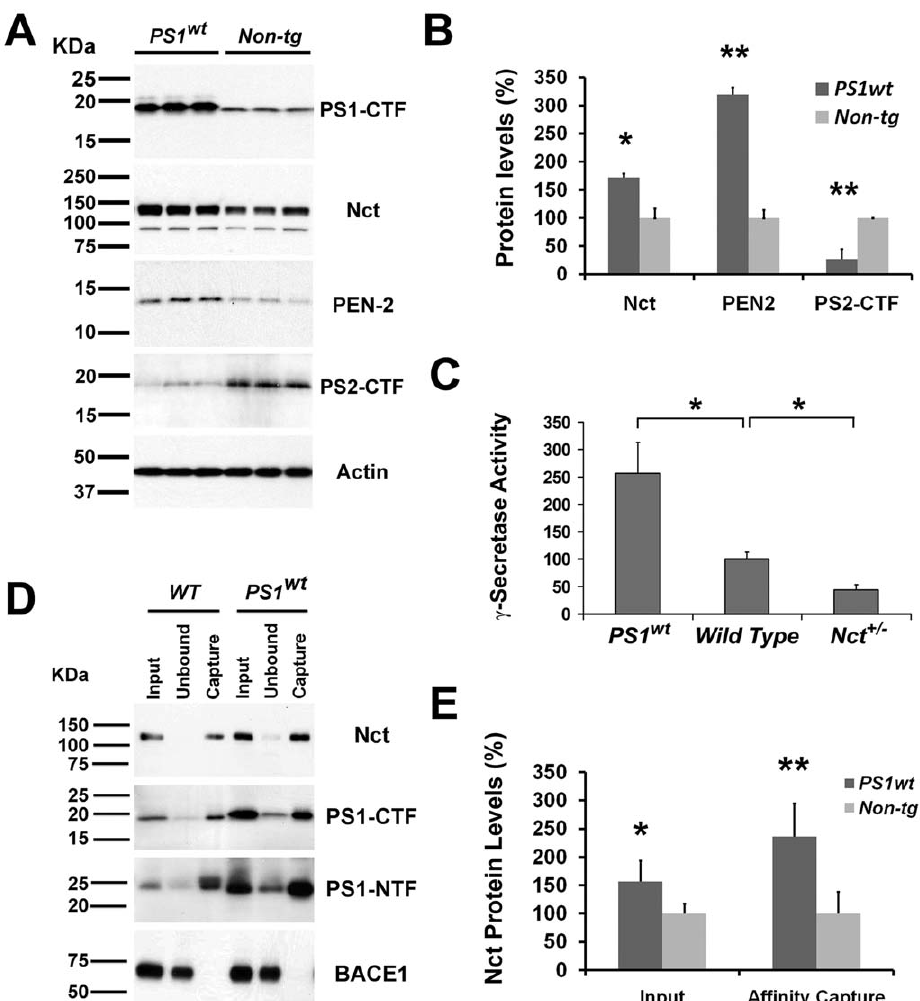
Figure 1. Increase of c -secretase activity in brains of PS1 mice. (A) Protein extracts (20 m g each) from brains of PS1 transgenic (lanes 1–3) and non-transgenic mice (lanes 4–6) were immunoblotted with anti-sera specific to Nct, PS1-CTF, PEN2, PS2-CTF, or Actin. (B) Quantification of signals of Nct, Pen-2, and PS2-CTF in protein blots by Image J program. The signal density was normalized using Actin signals derived from the same blot. (C) In vitro c -secretase assay of brain extracts of wild type, PS1 transgenic, and Nct + / 2 mice. The data were average from 4 samples. (D) The CHAPSO solubilized membrane proteins from wild type and PS1 transgenic mice were incubated with Compound 4 followed by precipitation with streptavidin-coupled beads. Solubilized membranes before ligand addition (Input: 10% of total), captured fraction (Capture : 20% of total) of the affinity ligand and the corresponding supernatants after capture (Unbound: 7.5% of total) were analyzed by Western blot using antisera specific to Nct, PS1-CTF, PS1-NTF, or BACE1. (E) Quantification of signals of Nct levels from in protein blots by Image J program. The signal density was normalized using BACE1 signals derived from the same blot.